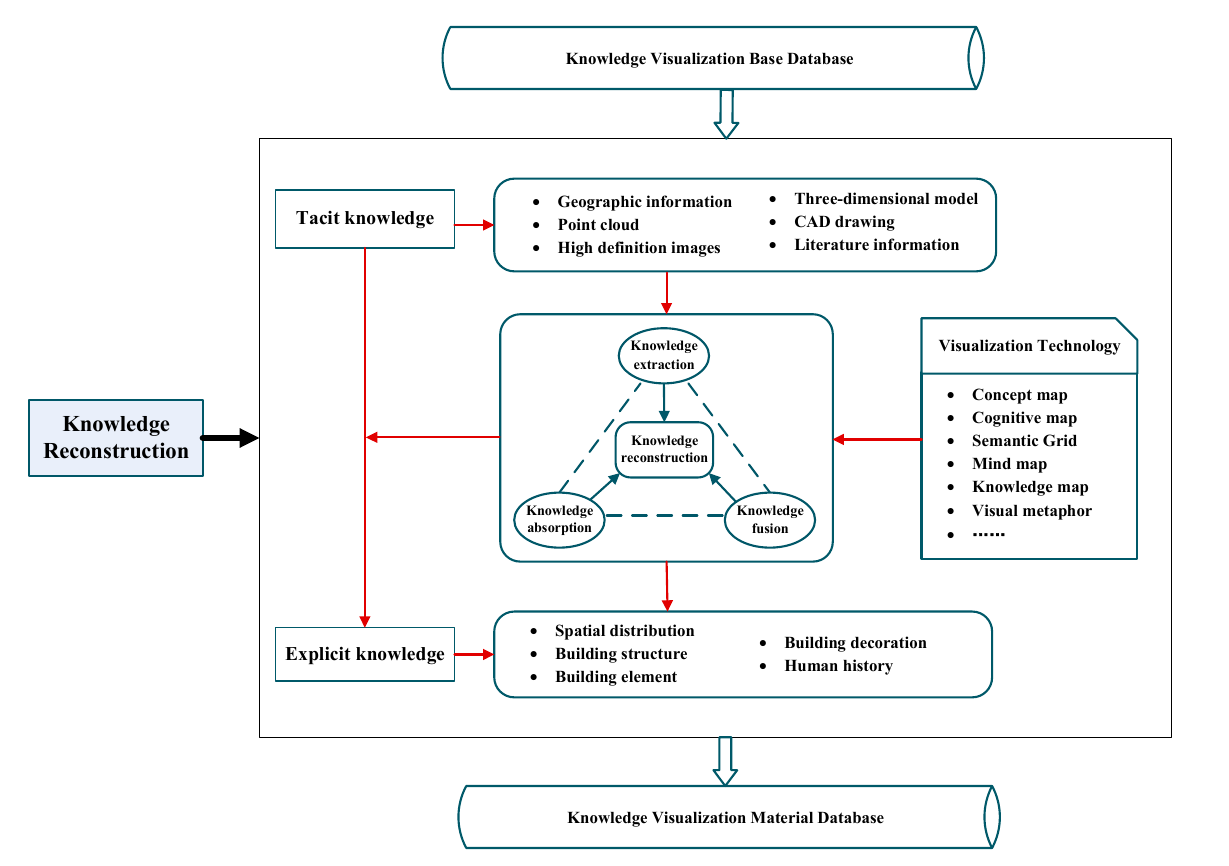
Figure 3. Technical framework of the knowledge reconstruction.